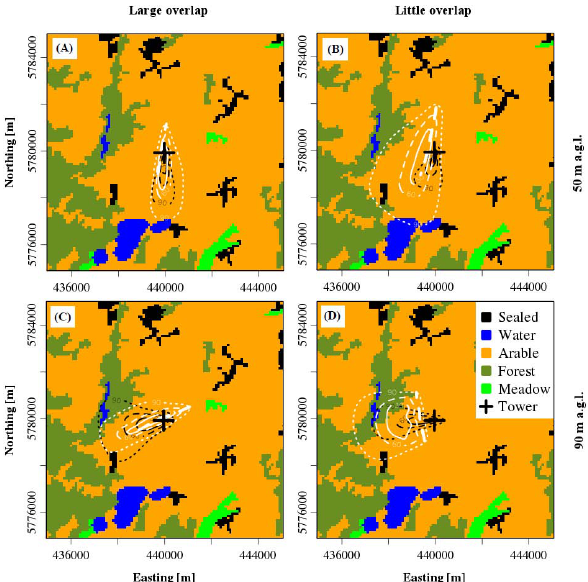
Fig. 7. Footprint effect levels of four simultaneous tower and WSMA measurements against the background of the Corine Land Cover raster (10 × 10km). The flight path (white dashed line) and the footprint effect levels are shown. Solid, dashed and dotted lines represent a cumulative footprint of 30%, 60% and 90%, respec- tively. Flights (A) and (B) on 15 October 2008, 14:51–14:52UTC and 14:09–14:12UTC at 50ma.g.l. Flights (C) and (D) on 16 Oc- tober 2008, 11:36–11:38UTC and 11:09–11:10UTC at